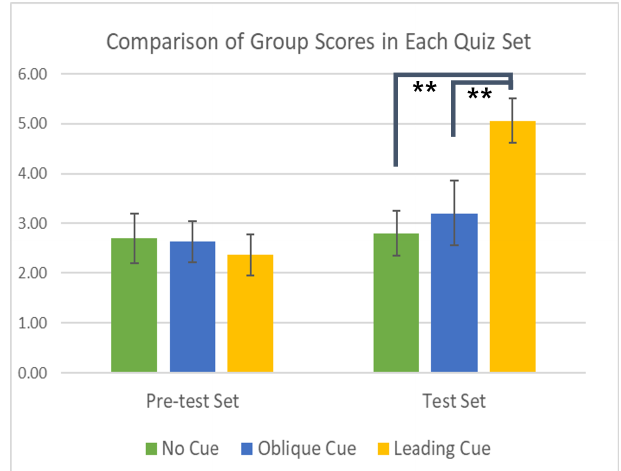
Figure 2. Comparison of group scores in each quiz set (NC: no cue, OC: oblique cue, and LC: leading cue). A double asterisk indicates statistically significant difference ( p <0.01).